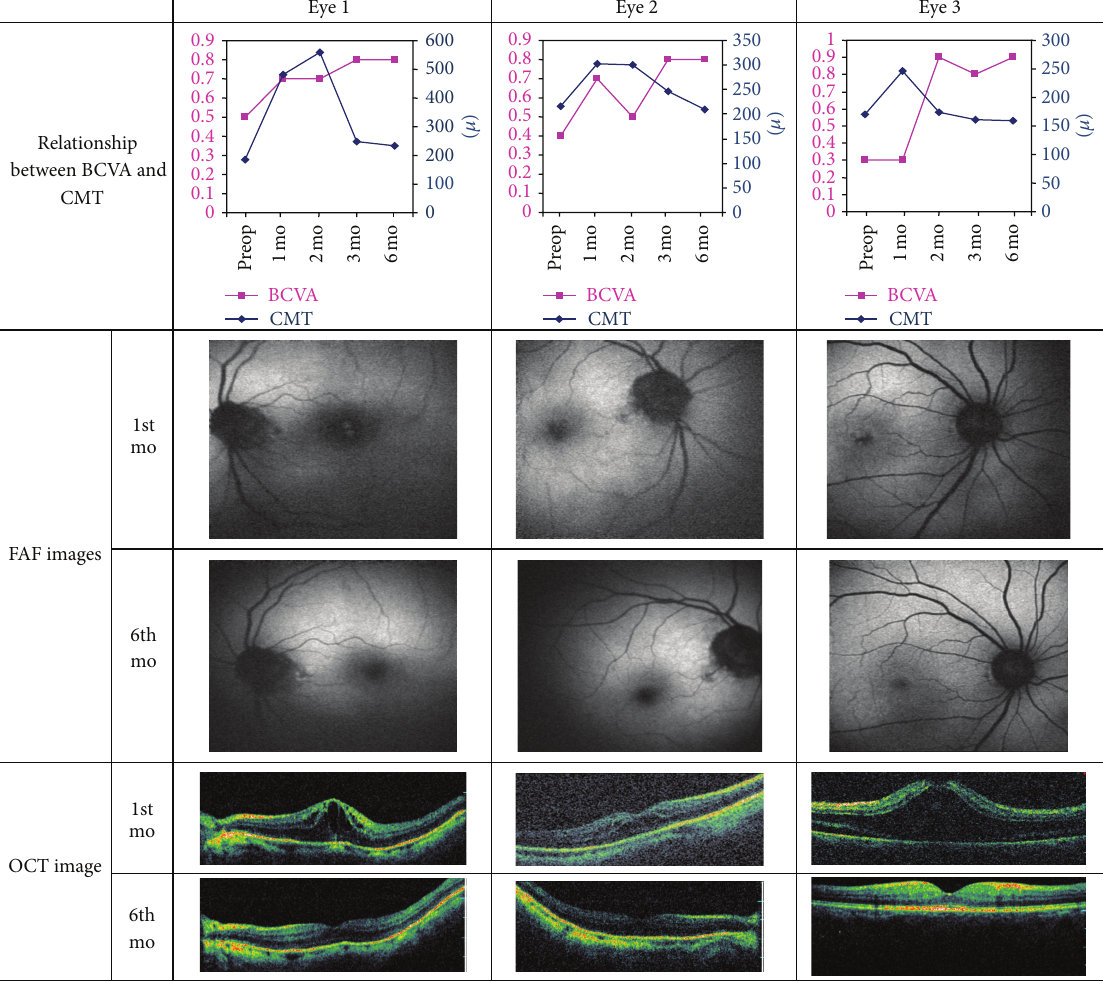
Figure 1: Fundus autofluorescence and optical coherent tomography images and the relationship between the best corrected visual acuity and central macular thickness of the eyes with CME. BCVA: best corrected visual acuity; FAF: fundus autofluorescence; OCT: optic coherence tomography; Preop: preoperative; Postop: postoperative; mo: